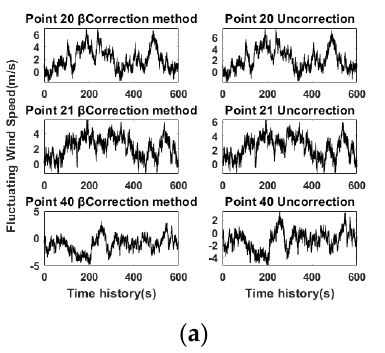
Figure 5. The distribution of correction factor of simulated points for two-dimensional space. The modified simulated point fluctuating wind speed diagram is shown as Figure 6.